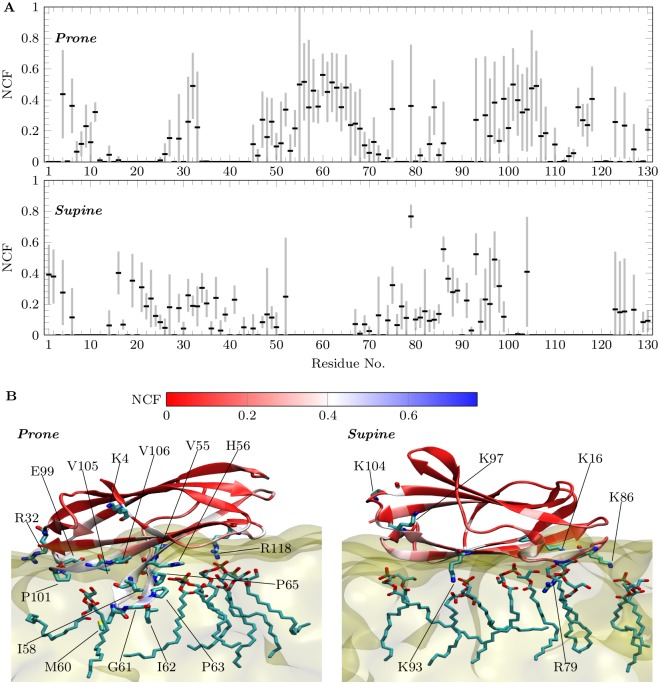
Normalized contact frequency analysis (ncf).A) The black rectangles show the ncf averaged over all bmp mixtures (bmp:chol:sm:dopg:popc = 20:10:0:0:70 (System 5), 20:35:0:0:45 (System 6) and 20:10:20:0:50 (System 7)), and the gray bars show the standard deviation. B) Representative snapshots showing npc2 interacting with bmp in Prone mode (left) and Supine mode (right). The protein is colored based on the ncf and the residues with ncf > 0.4 are shown in licorice and labeled.